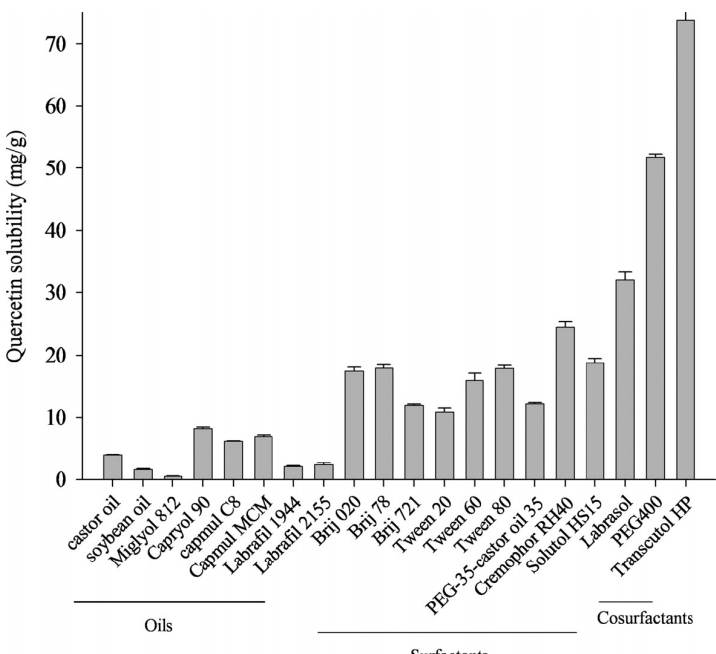
Figure 10. Quercetin solubility in a variety of oils, surfactants, and cosurfactants [44].